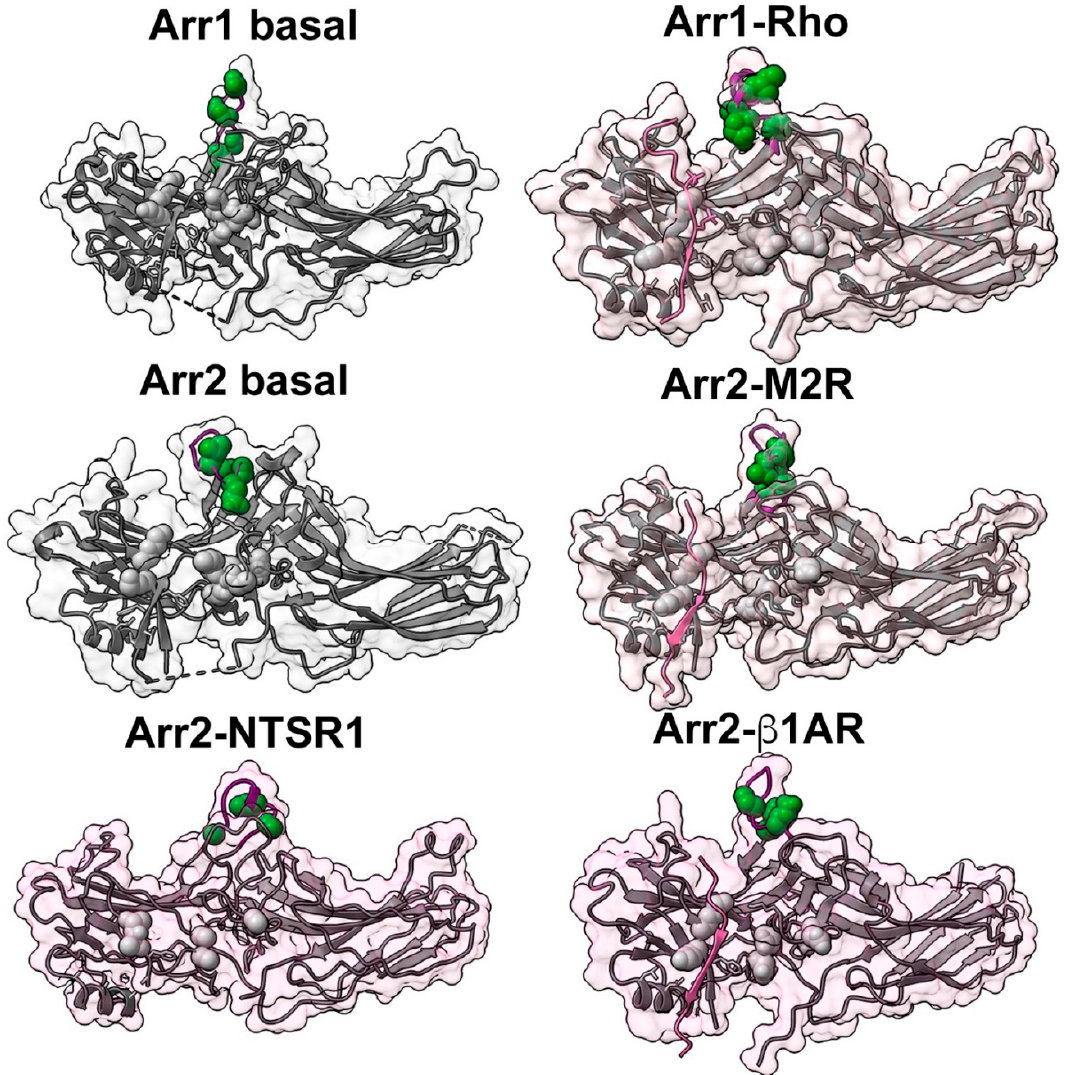
Figure 5. Finger loop as the activation sensor. The structure of the finger loop in basal bovine arrestin-1 (Arr1 basal; PDB 1CF4 [24]), mouse arrestin-1 in complex with rhodopsin (Arr1-Rho, PDB 5W0P [6]), basal arrestin-2 (Arr2 basal, PDB 1G4M [25]), arrestin-2 in complex with M2 muscarinic (Arr2-M2R; PDB 6U1N [8]), β 1-adrenergic (Arr2- β 1AR; PDB 6TK0 [9]), and NTSR1 neurotensin (Arr2-NTSR1; PDB 6UP7 [10]) receptors. Note that in receptor-bound arrestins, the finger loop can form a short α -helix (Arr1-Rho, Arr2-NTSR1) or a different secondary structure (Arr2- β 1AR, Arr2-M2R). Finger loop and adjacent residues identified as critical for recognizing the active state of the receptor in bovine arrestin-1 (Gly68, Glu70, Ile72, Phe79 [36]) and homologous conserved arrestin-2 residues (Gly64, Glu66, Ile68, Phe75) are shown as CPK models in dark green. Polar core residues (Figure 1) and the two lysines in the β -strand I (Figure 2) are shown as grey CPK models. Where resolved in structures, the phosphorylated receptor C-terminus is shown in red. Receptor-bound structures have a pinkish tinge.